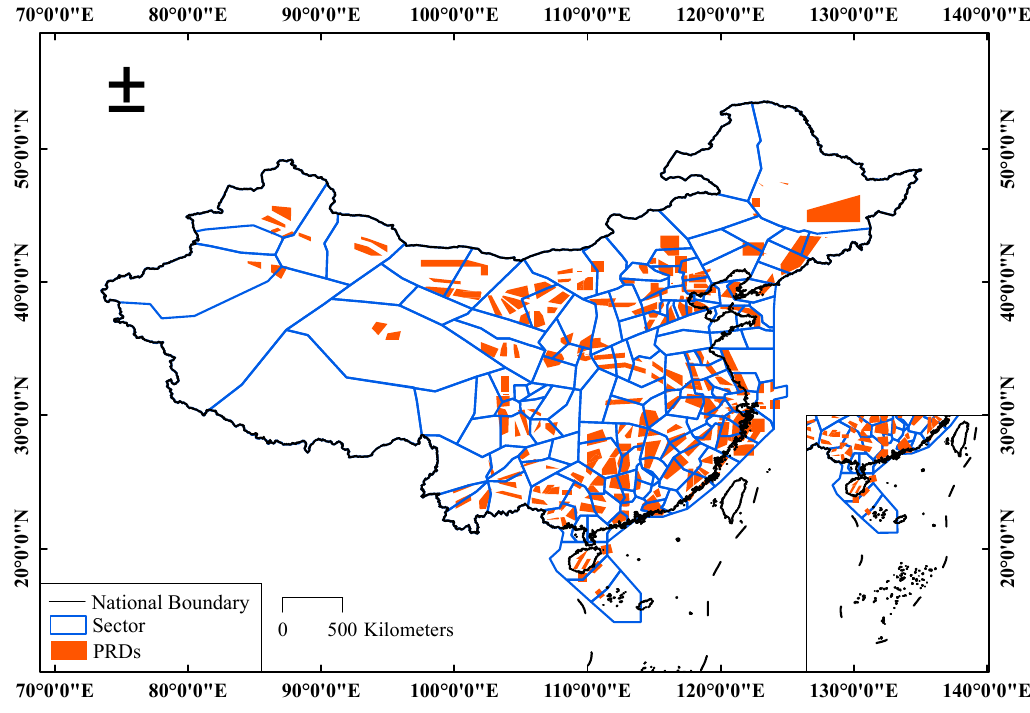
Figure 2. Distribution of airspace elements.